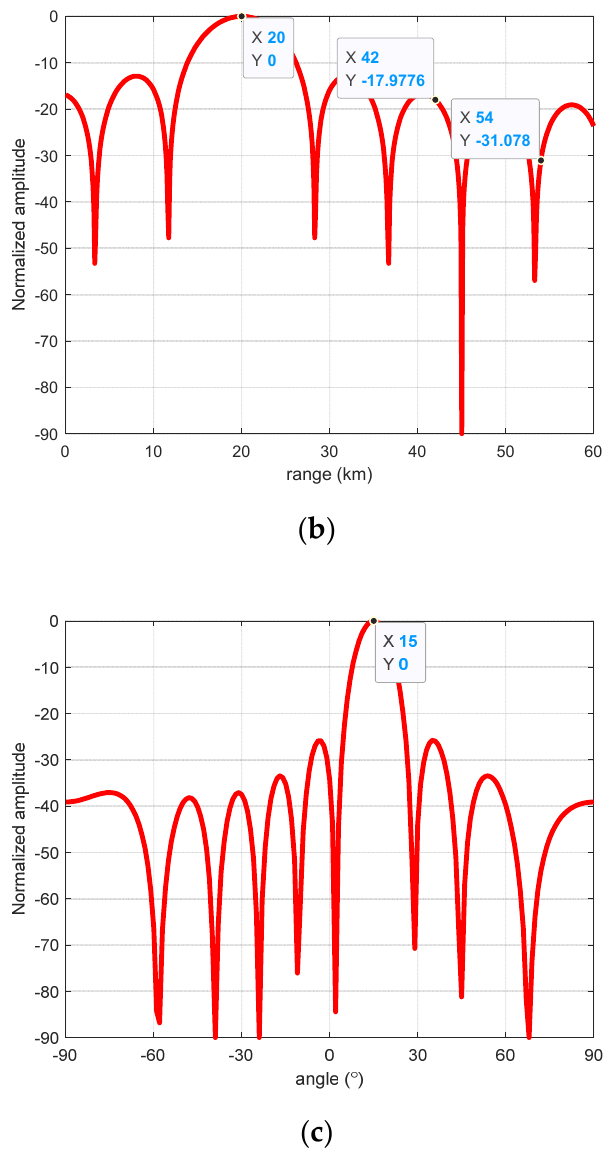
Figure 5. FDA-MIMO non-adaptive beamforming gain. ( a ) Range-angle two-dimensional beamforming gain; ( b ) Range dimension; ( c ) Angle dimension.